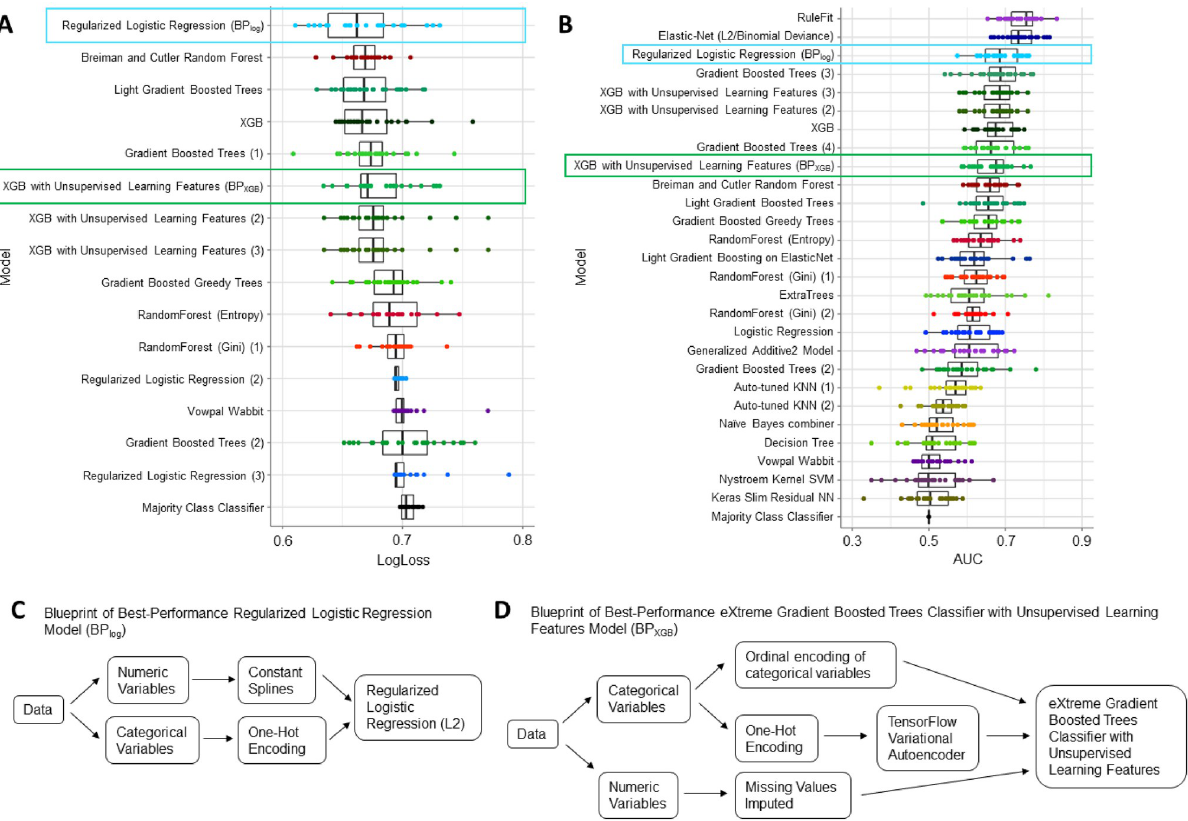
Fig 2. AutoML generated 15 models that performed better than the Majority Class Classifier model. Each model consisted of automatically implemented preprocessing steps and algorithms. Models were assigned names according to the algorithm and encoded by a unique color. Blueprints of the same algorithm class are numbered for identification across both (A) LogLoss and (B) Area Under Curve (AUC) plots. Two models were selected for additional analysis: BP log (blue box) and BP XGB (green box). Aggregating across 25 projects (unique partitioning arrangements of the dataset), BP log had an average performance of 0.67 ± 0.01 LogLoss and 0.68 ± 0.02 AUC; BP XGB had an average performance of 0.68 ± 0.01 LogLoss and 0.67 ± 0.02 AUC. (C) BP log consisted of a regularized logistic regression (L2) algorithm with a notable quintile spline transformation preprocessing step for numeric variables. (D) BP XGB implemented an eXtreme Gradient Boosted (XGB) trees classifier with unsupervised learning features, which refers to the TensorFlow Variational Autoencoder preprocessing step for categorical